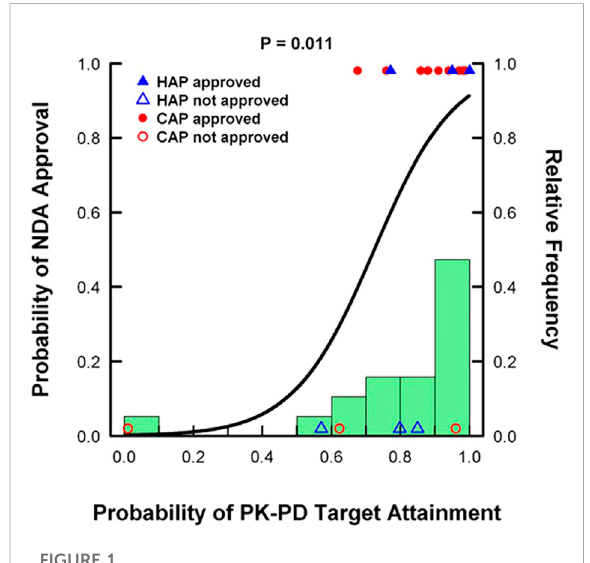
FIGURE 1 Analysis of 19 antibacterial drug approval candidates from 1996 to 2011 demonstrating the correlation between PK/PD PTA